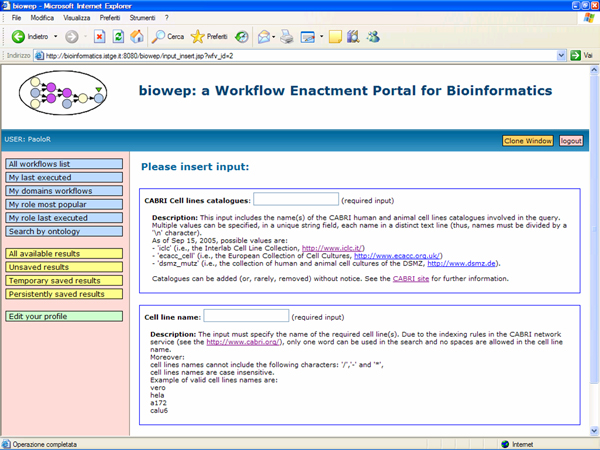
Input form for executing a workflow. In this figure, the input form for the execution of a workflow is shown. Input fields are described in details and suggestions for input values are given. Required and optional fields are pointed out.